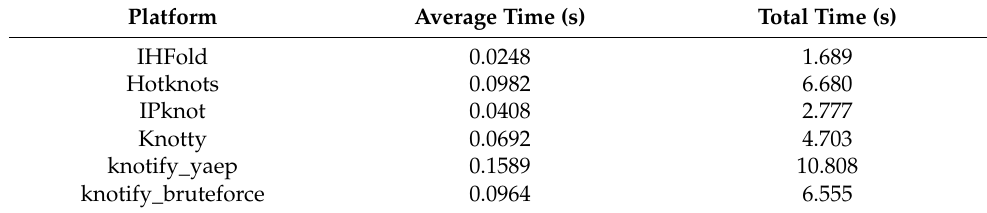
Table 12. Execution time required per platform in for RNA sequences of length >= 30 and < 40.